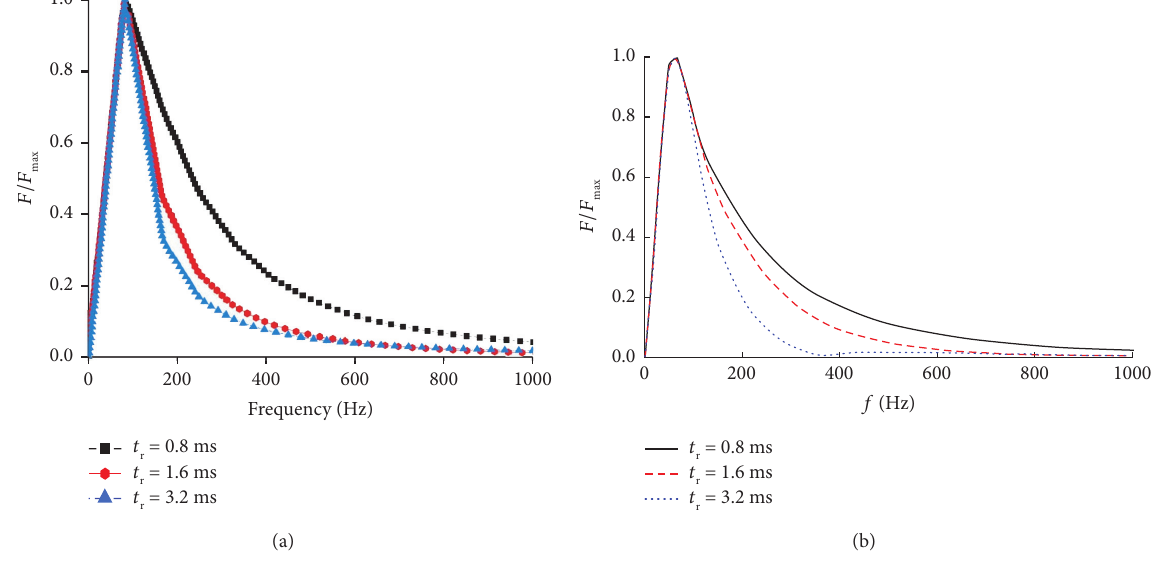
Figure 2: The effect of rise time on the frequency content: (a) in this study; (b) Yang et al.